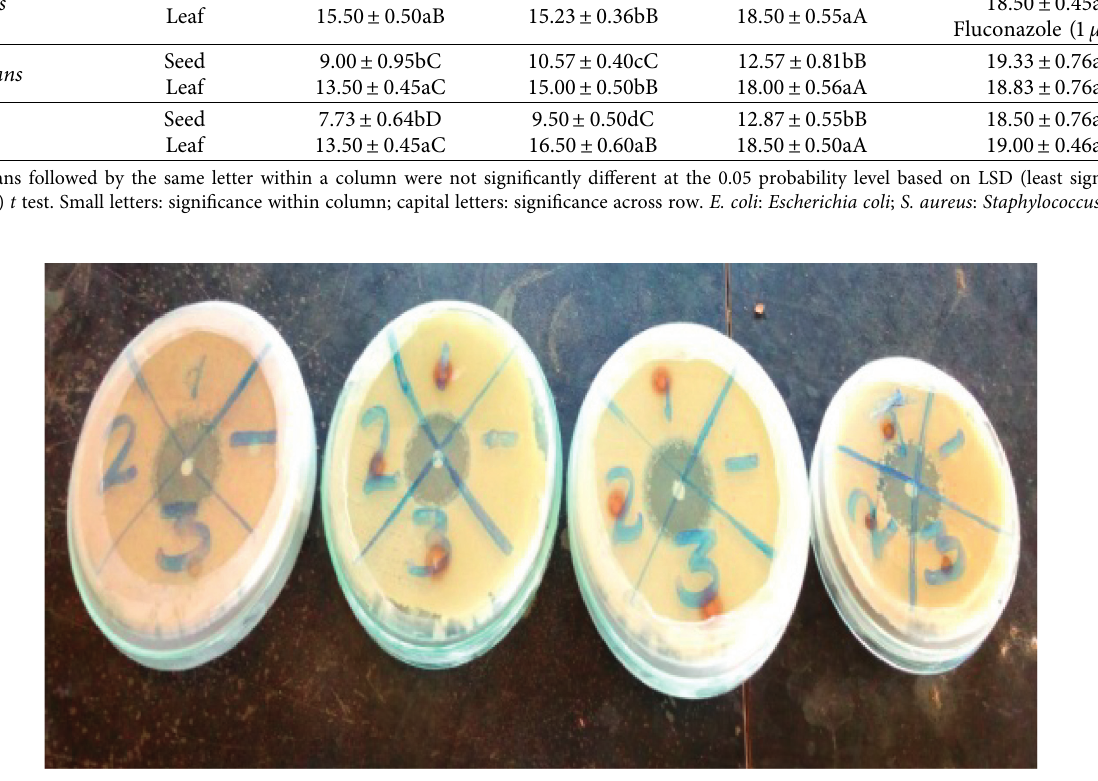
Figure 2: Zone of inhibition diameter showing the antimicrobial activity of the oil extracts.